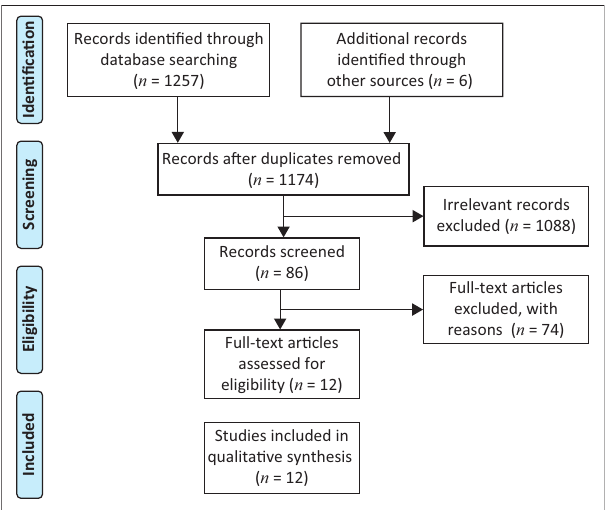
FIGURE 1: Prisma flow